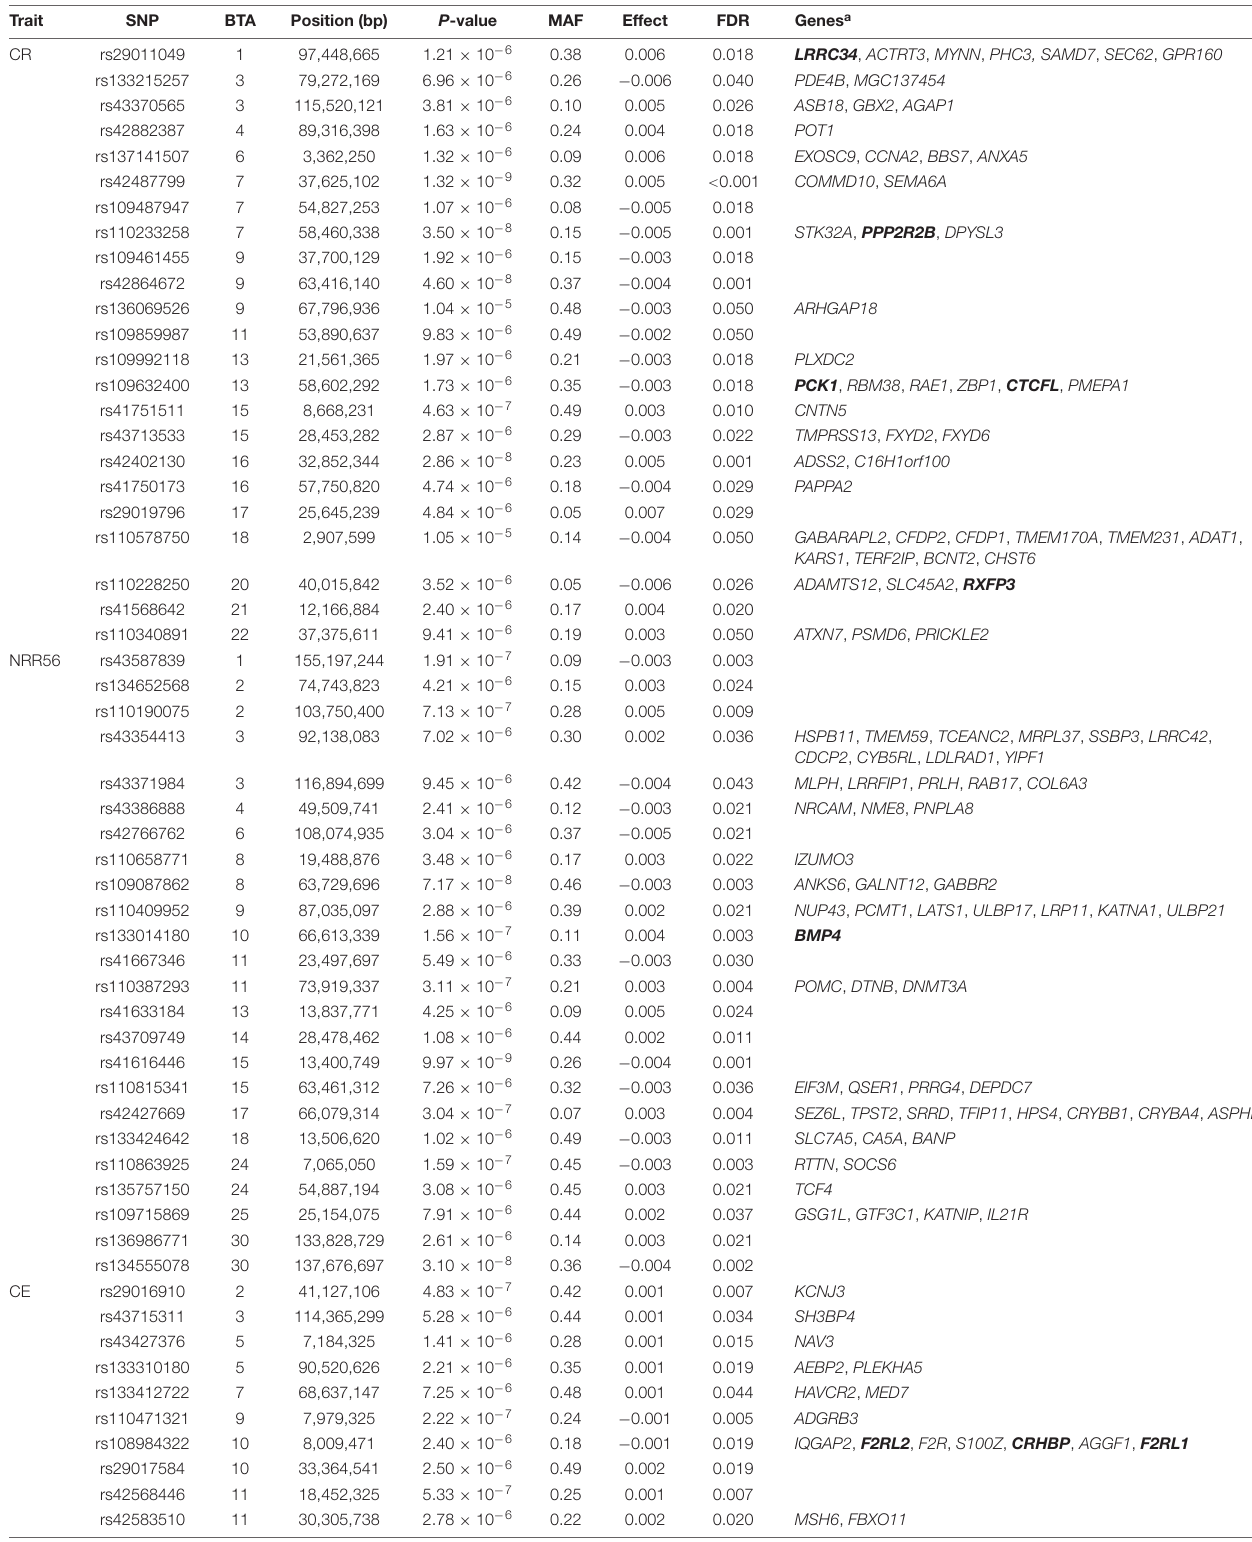
TABLE 4 | Significant single-nucleotide polymorphism (SNP) and nearby genes of the genetic effects of service sire on five reproductive traits carried out by genome-wide association studies in Holstein cattle.